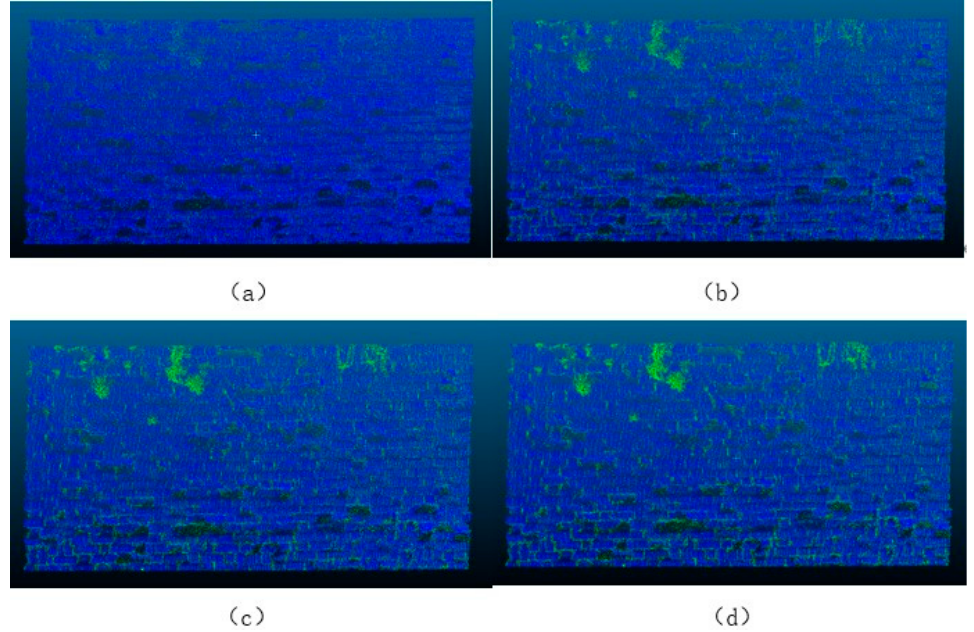
Figure 20. Point cloud marked by Curvature. ( a ) K = 4. ( b ) K = 6. ( c ) K = 8. ( d ) K =